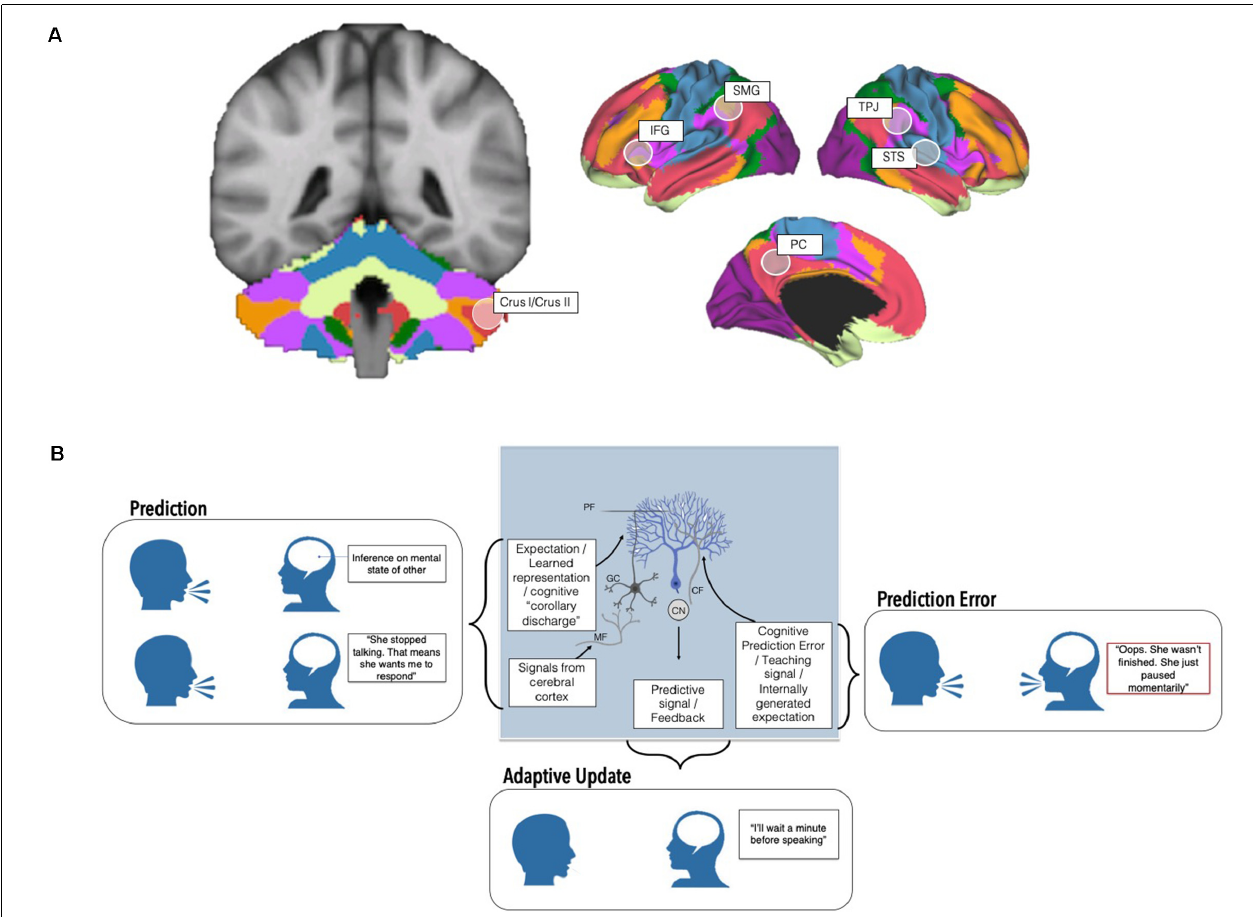
FIGURE 1 | Cerebellar contributions to adaptive prediction in social cognition from neurons to networks. (A) The posterolateral cerebellum, particularly Crus I/II, is a node of whole-brain cognitive resting state networks including the Default Mode (red) and Frontoparietal networks (orange; Buckner et al., 2011; Yeo et al., 2011; other networks visualized include dorsal (green) and ventral attention (violet), somatomotor (blue), visual (purple), and limbic (cream)). In addition to resting state networks, several task-based neuroimaging studies find that discrete regions of the cerebellum are maximally engaged by specific tasks (e.g., Stoodley and Schmahmann, 2009; Guell et al., 2018; King et al., 2019). This cerebellar region is also functionally connected with and consistently activated alongside regions implicated in theory of mind (right temporoparietal junction, TPJ, right superior temporal sulcus, STS, and the precuneus, PC) and language processing (left inferior frontal gyrus, IFG, left supramarginal gyrus, SMG). (B) At the cellular level, Granule cells (GC) receive input from the rest of the brain and spinal cord via mossy fibers (MF) and may transmit expectation-related information via their parallel fiber (PF) axons to Purkinje cells, the principal neurons of the cerebellum. On the other hand, prediction errors are carried by climbing fibers (CF) originating in the inferior olive, which also synapse onto Purkinje cells (blue). Climbing fiber input to Purkinje cells is thought to signal which granule cell signals are most important in a given context (Wagner and Luo, 2020 for review). Predictive signals and feedback are ultimately relayed to the rest of the brain via output from the cerebellar nuclei (CN). These circuits, and interactions between the cerebellum and the rest of the brain, ultimately enable the creation and deployment of predictions, prediction errors, and adaptive changes to behavior. Altered cerebellar cytoarchitecture, circuitry, and connections with the cerebrum may affect different aspects of adaptive predictions with relevance for sociocognitive challenges in